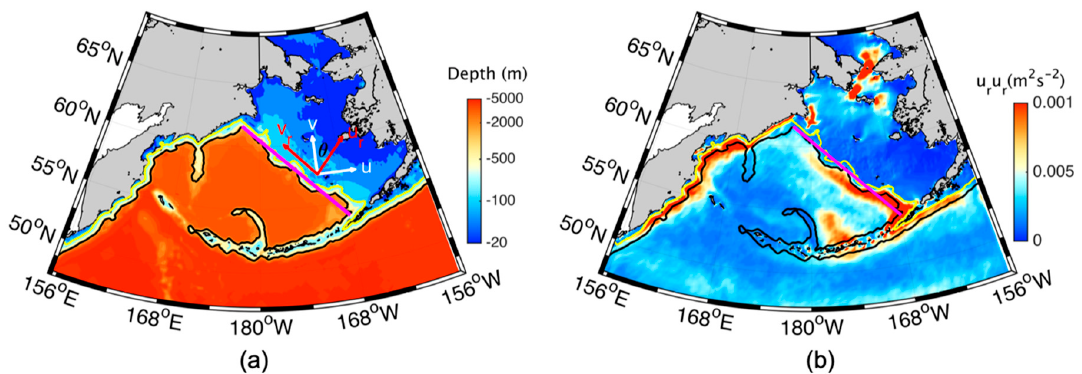
Figure 14. Eddy transport: ( a ) schematic diagram of the method and ( b ) eddy transport across the Bering Slope, which is calculated from the 5 day averaged 15 year data (1990–2004) model data (Unit: m 2 s − 2 ). The black and yellow lines represent the 1500 m isobath and 200 m isobath, respectively. The straight magenta line is approximately 1500 m of isobaths, which represents the Bering Slope.